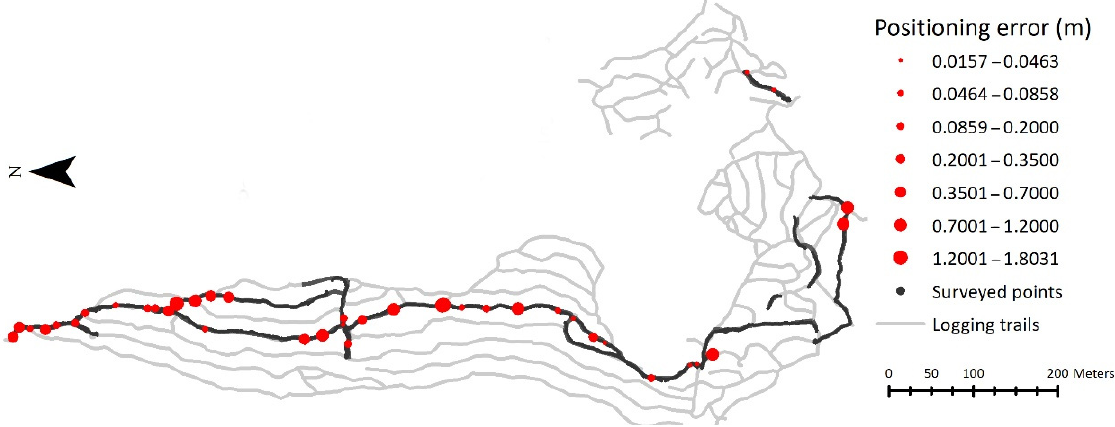
Figure 4. Distribution of absolute errors of positions recorded for u-blox ZED-F9P in control points.